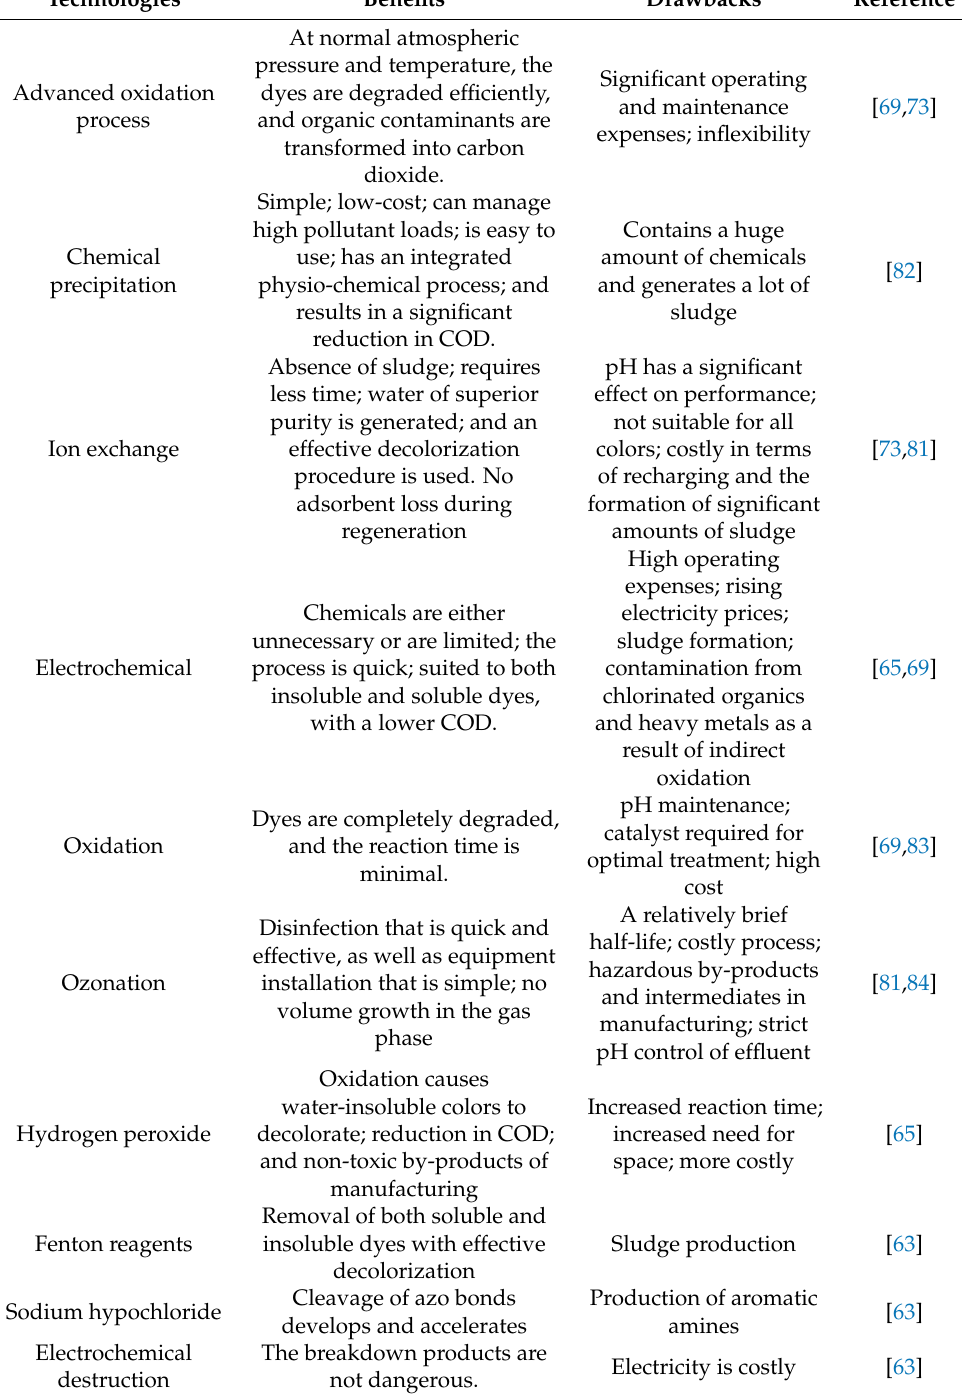
Table 2. Benefits and drawbacks of various wastewater treatment technologies for MB’s